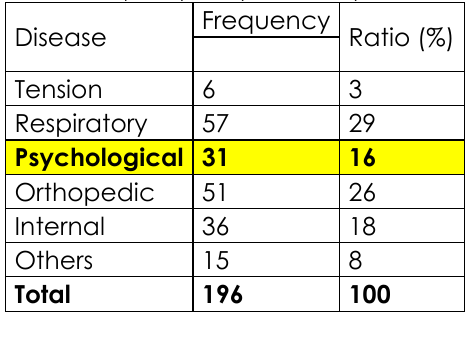
Table 2. Frequency Analysis of Survey